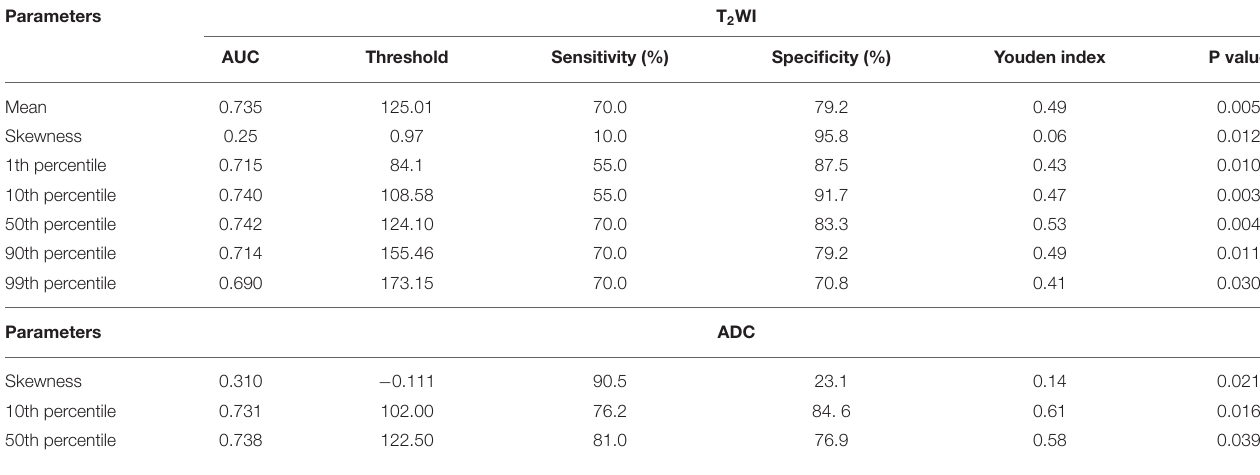
TABLE 5 | Diagnostic efficacy of the histogram parameters for endometrial mesenchymal sarcoma and degenerative hysteromyoma.